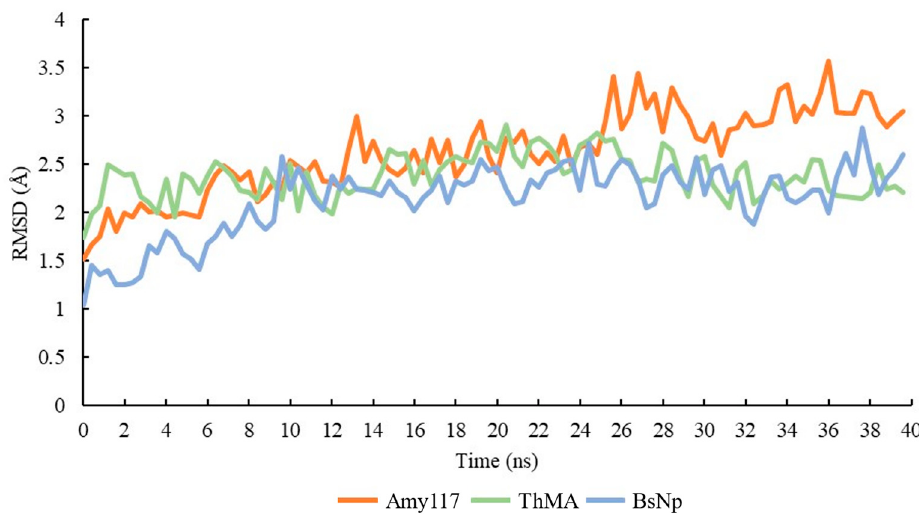
Figure 6. RMSD of Amy117, ThMA, and BsNp.